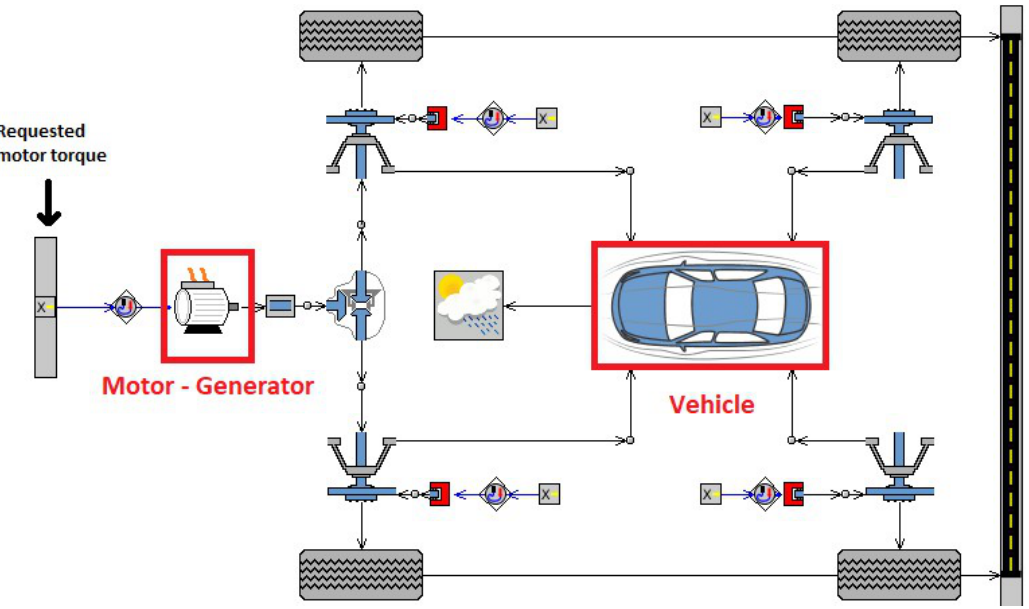
Figure A3. GT-SUITE diagram of the powertrain—vehicle frame and motor—generator.